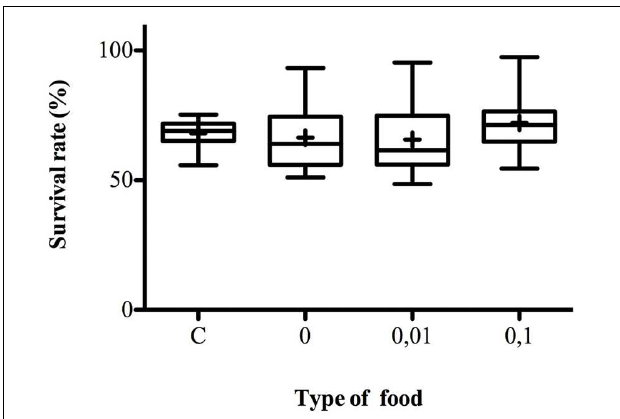
FIGURE 5 | Survival rate on control and menthol-enriched food. The box-and-whisker plots show the survival rates on different types of food, C, control food, 0%, no menthol plain-Food, 0.01, 0.01% menthol-enriched food, 0.1, 0.1% menthol-enriched food. Females were given the choice to lay eggs on four different oviposition sites with increased menthol concentration ranging from 0 to 0.5%. For each site larvae were raised at 25 ◦ C until complete development. For Control-line survival rate is measured in a multiple choice assay with four sites filled with control food and flies from parental lines never exposed to menthol. Adults were counted at emergence and survival rate was measured. N = 10–16. For more information, refer to Figure 1